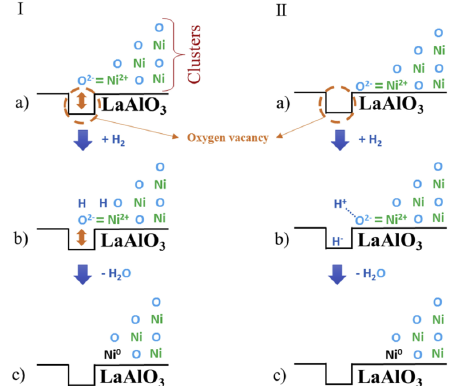
Figure 5. Scheme of the reduction/activation mechanism of the Ni catalyst supported on LaAlO 3 catalysts. ( I ) — Terminal oxygen ion of the NiO clusters located on the surface oxygen vacancy. ( II ) — Terminal oxygen ion of the NiO clusters located adjacent to the surface oxygen vacancy. Reproduced with permission from reference [107].